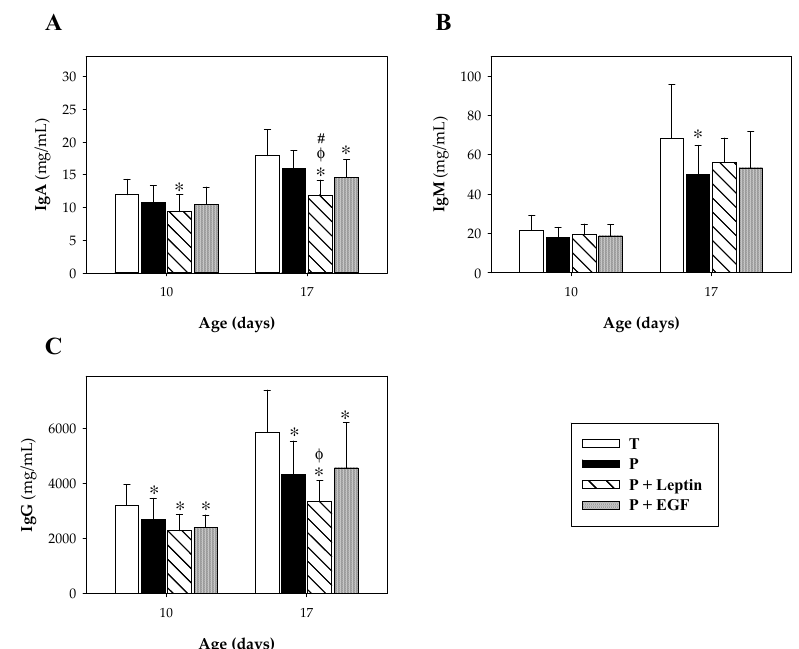
Figure 3. Plasma Ig concentrations at day 10 and 17. Plasma IgA ( A ), IgM ( B ), and IgG ( C ) concentrations from the four groups: Term (T), Preterm (P), P+Leptin, and P+epidermal growth factor (P+EGF), are expressed as mean ± SD ( n = 8–12 pups/group). Statistical differences: * p < 0.05 versus T group; φ p < 0.05 versus P group; # p < 0.05 versus P+EGF group.